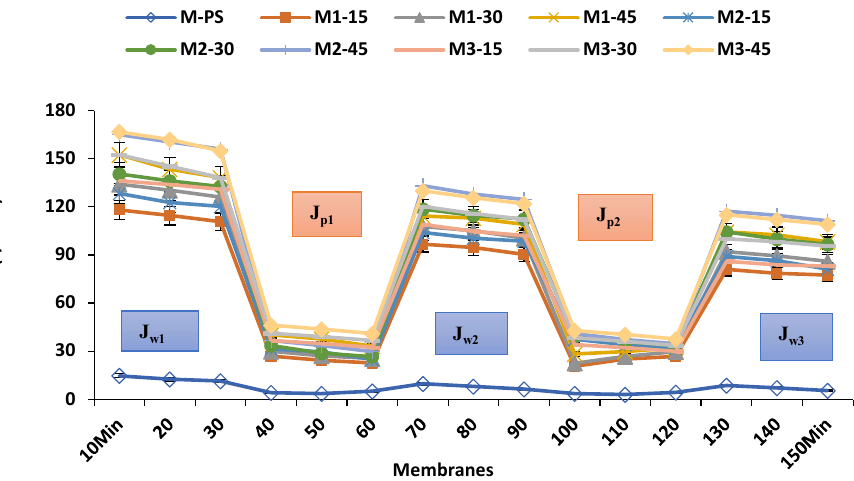
Figure 12. Initial pure water flux, BSA solution flux and after-washing flux for all prepared membranes.